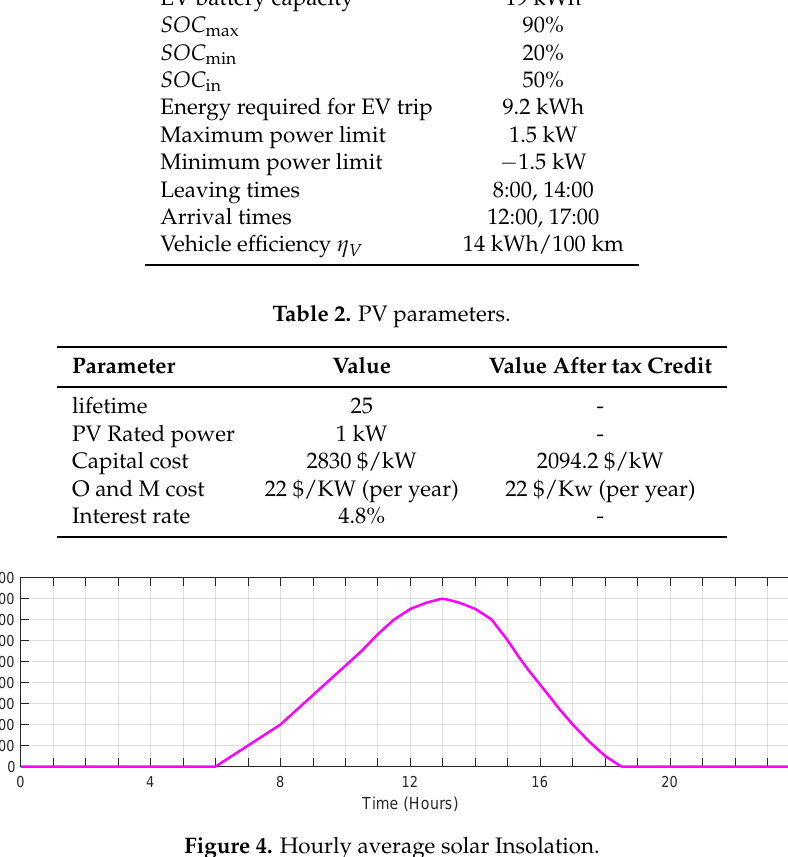
Figure 4. Hourly average solar